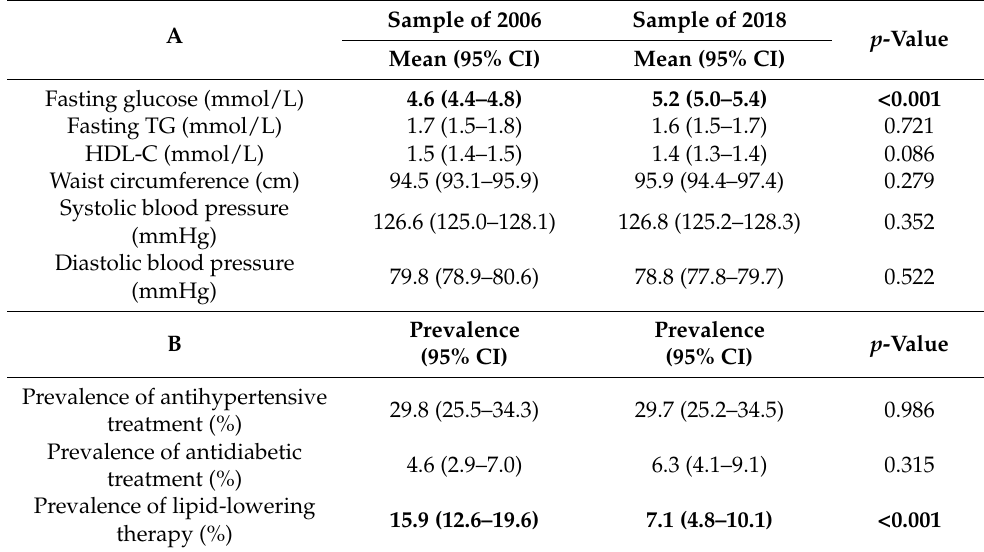
Table 1. Biochemical and physical parameters and the frequency of preventive medications used to estimate the prevalence of metabolic syndrome in the study